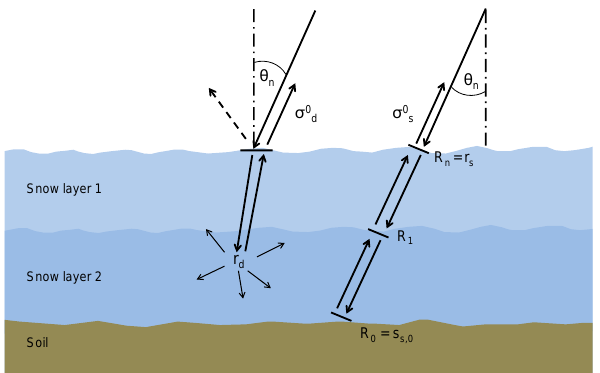
Figure 1. Snowpack (blue) with slightly undulated snow surface and layers. Waves incident at nadir angle θ n are refracted at the snow surface followed by volume scattering with backscatter σ 0 (left). Specular backscatter σ 0 s from a slightly tilted patch of the surface, soil and layer interfaces (right). Diffuse r d and specular reflectivities r s = R n , R 0 and R 1 are